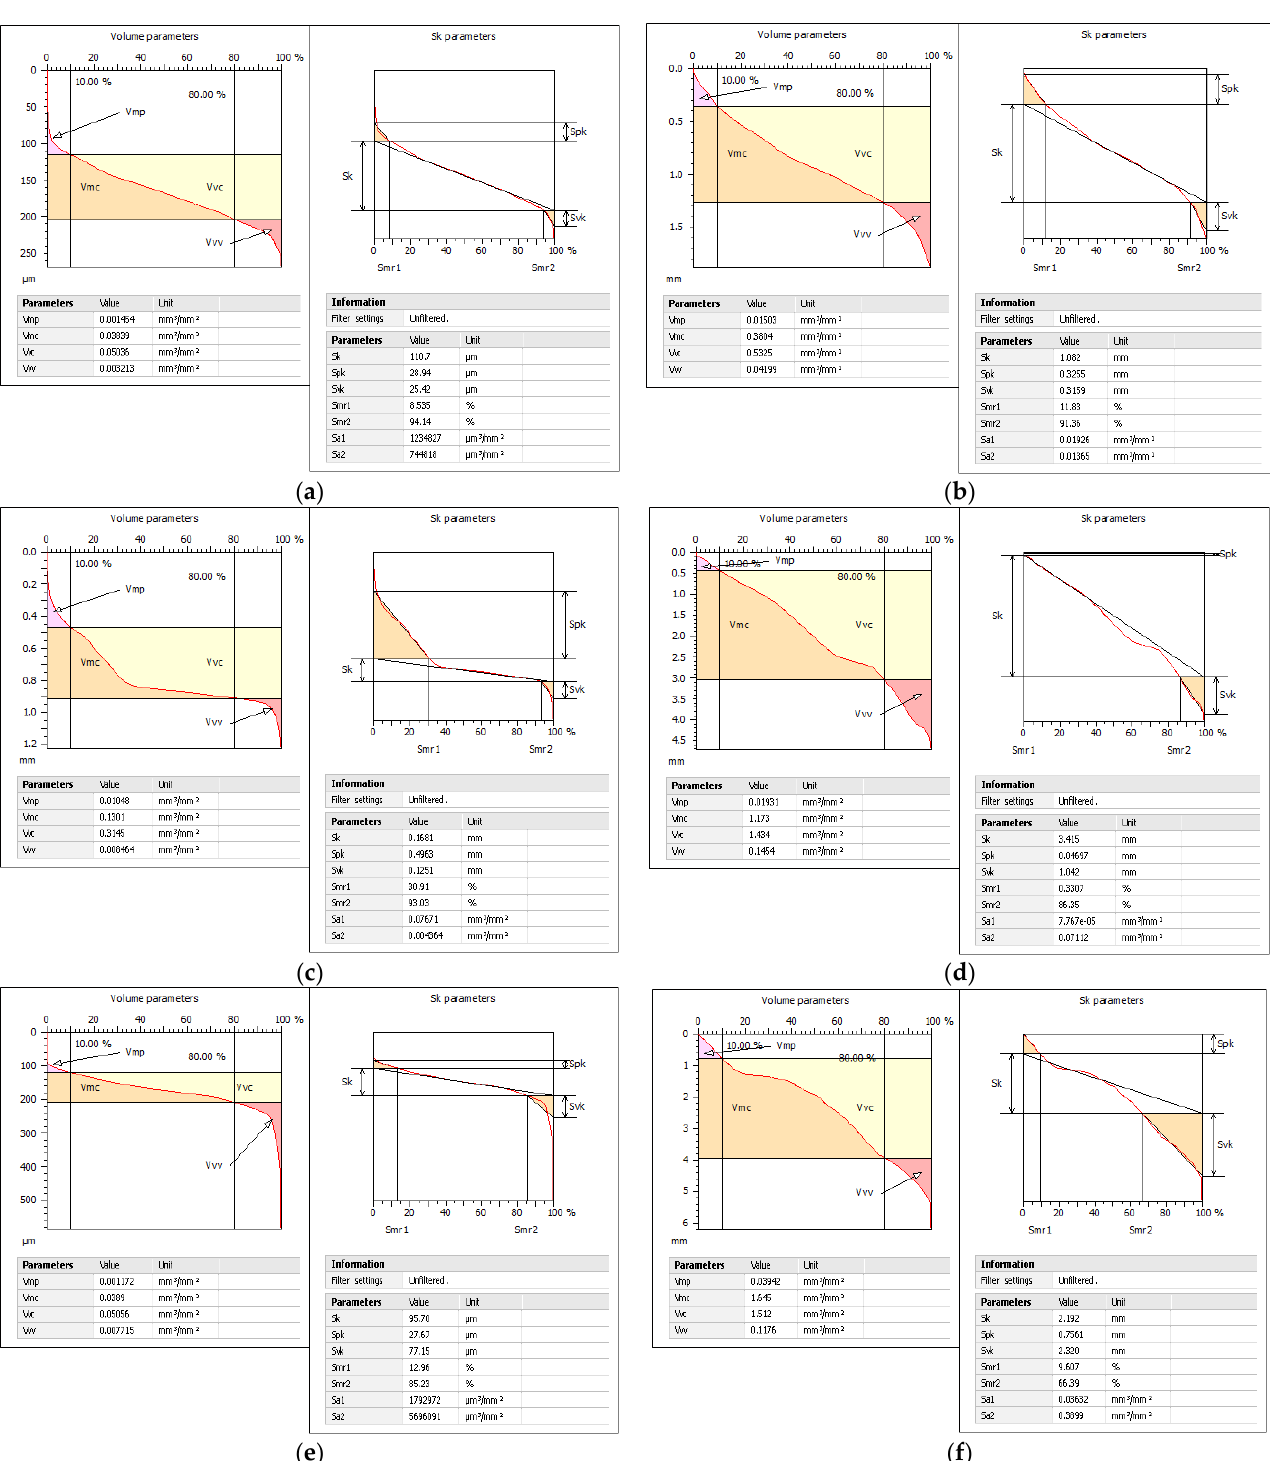
Figure 12. Volume and Sk parameters of fracture extremal Df values for: ( a ) max. 10HNAP; ( b ) min. 10HNAP; ( c ) max. 2017-T4; ( d ) min. 2017-T4; ( e ) max. S355J2; ( f ) min. S355J2.